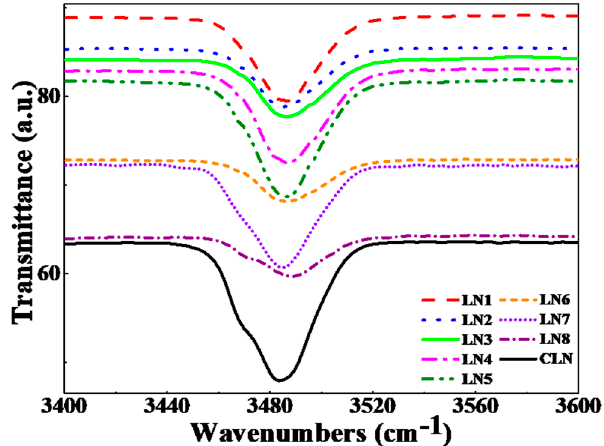
Figure 4. OH − absorption spectra for LN1-LN8 and CLN (top to bottom) crystals.